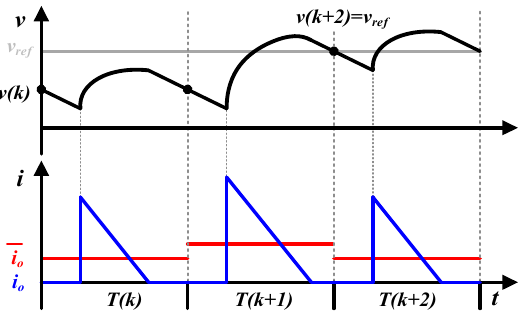
Figure 2. Output voltage and current under charge balance principle.